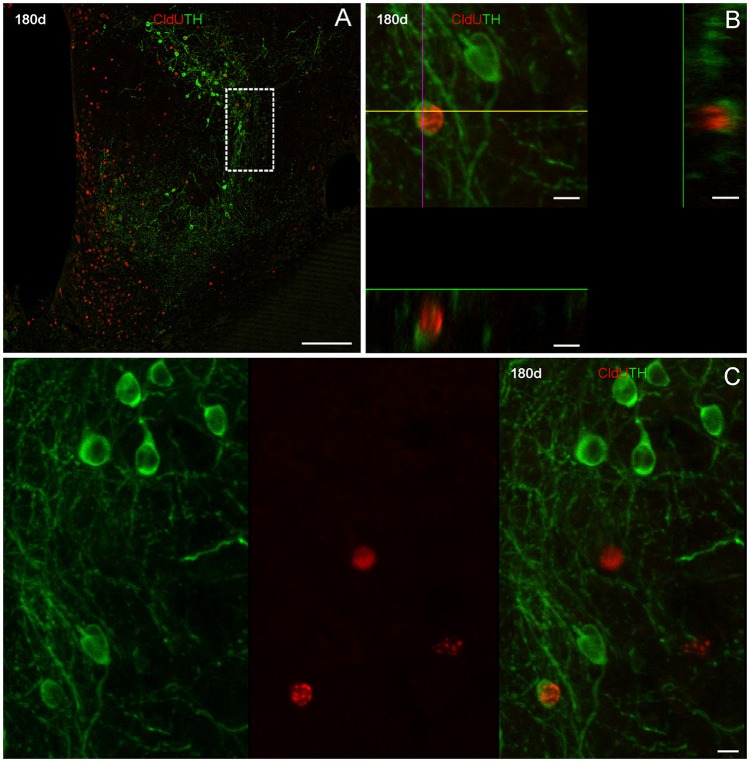
Neuronal differentiation in the rostral subpallium at 180 days after four daily injections of CldU demonstrated by co-localization with TH. (A) Maximal intensity projection of 15 confocal planes taken every 2 μm at the rostral subpallium. (B)
x-z and y-z orthogonal projection of 25 confocal planes, every 2 μm, confirming the co-localization of CldU and TH in a cell at the region indicated by the dotted rectangle in (A). (C) Co-localization of TH and CldU is also confirmed by the overlay of the sequentially acquired channels a single plane. Scale bars (A) 100 μm; (B,C) 5 μm.